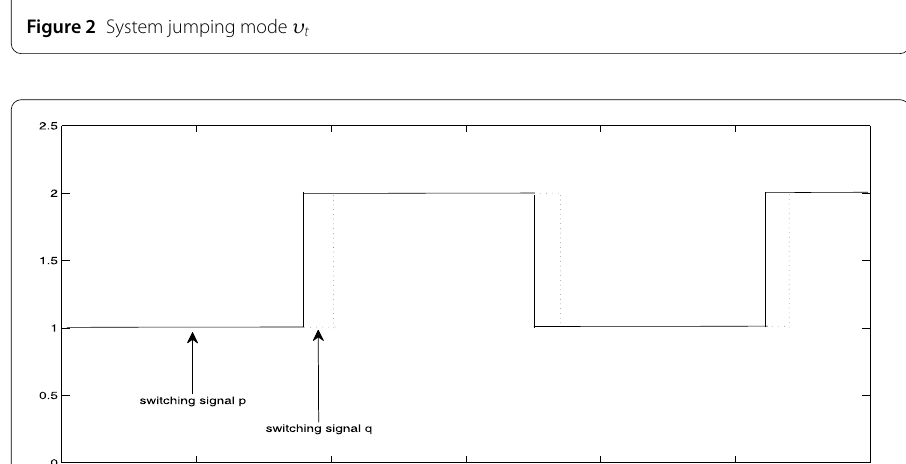
Figure 3 Switching signals ϑ t and ˜ ϑ